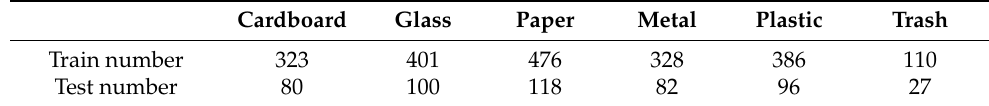
Table 4. Number of samples for each category in the training set and test set.